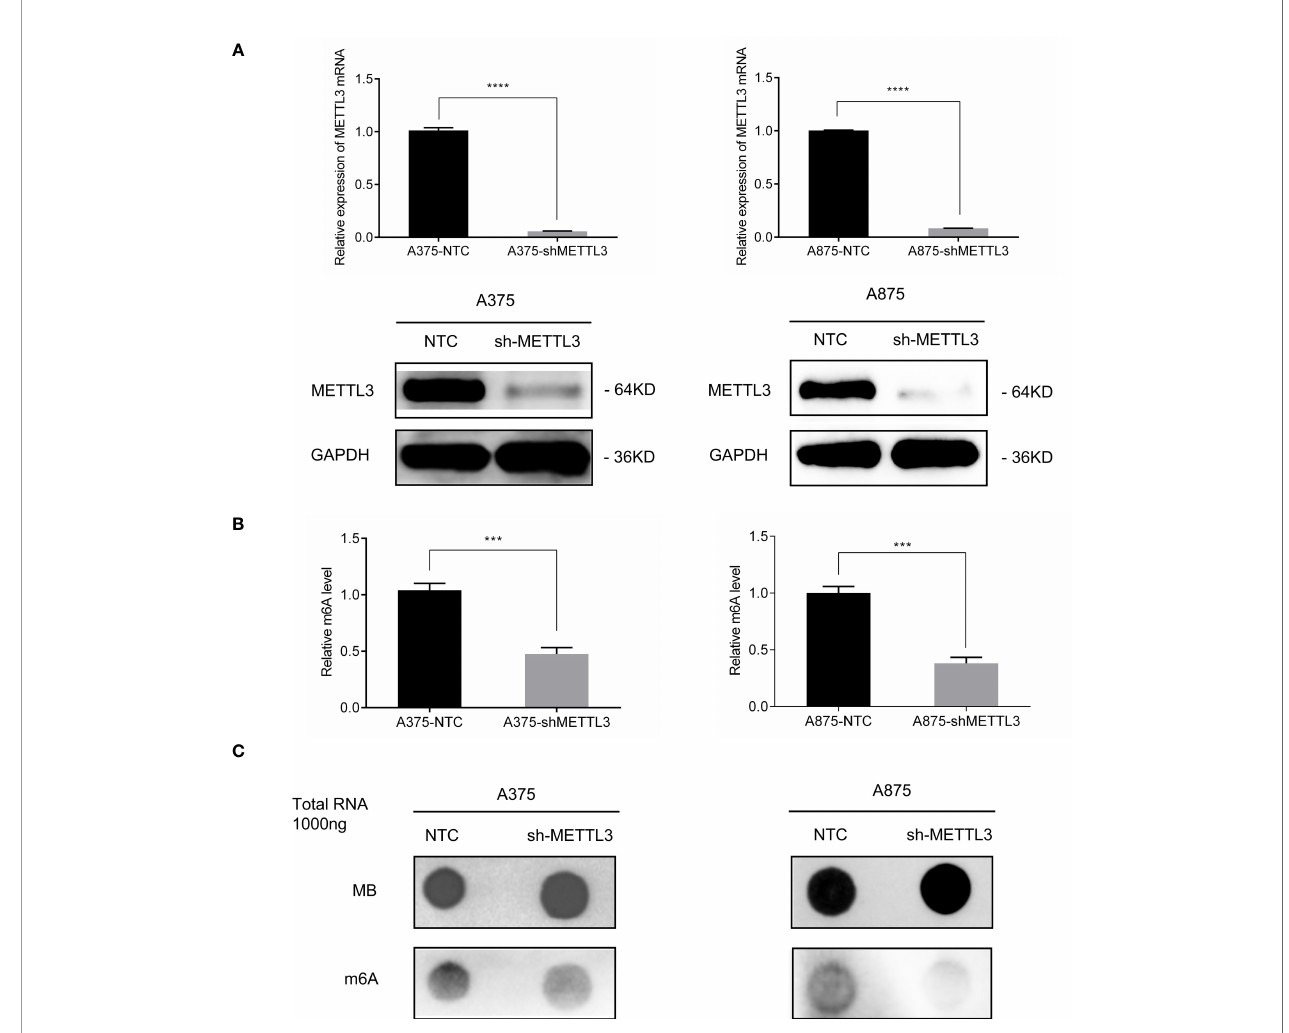
FIGURE 2 | METTL3 silencing decreased global m 6 A level in melanoma cell lines. (A) METTL3 mRNA and protein levels showing knockdown ef fi ciency in A375 and A875; bar chart showing data from three independent experiments; mean ± SD of each group. (B) m 6 A modi fi cation levels were decreased both in A375-shMETTL3 and A875-shMETTL3 as determined via colorimetric ELISA. (C) Dot blots showing relative total RNA m 6 A (bottom) and loading control (top). Data are presented as the mean ± SD. ***p < 0.001,****p <